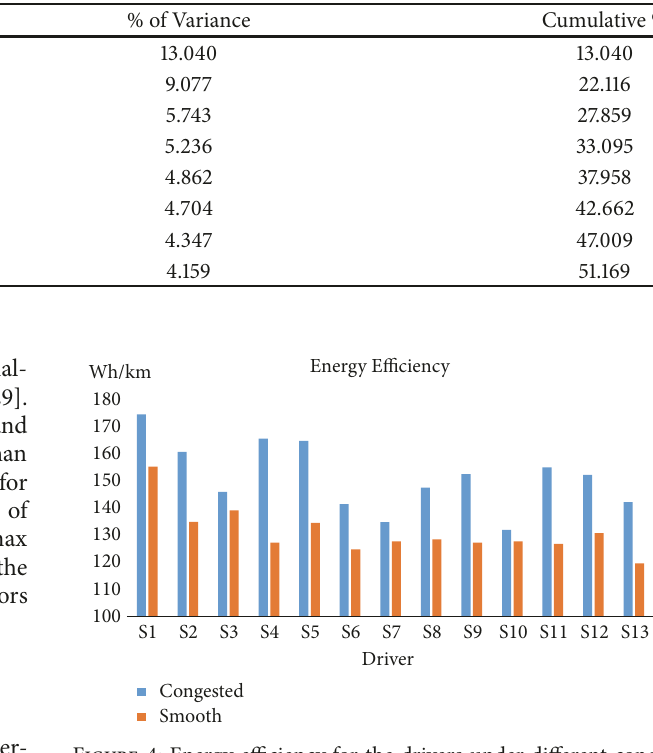
Figure 4: Energy efficiency for the drivers under different condi-